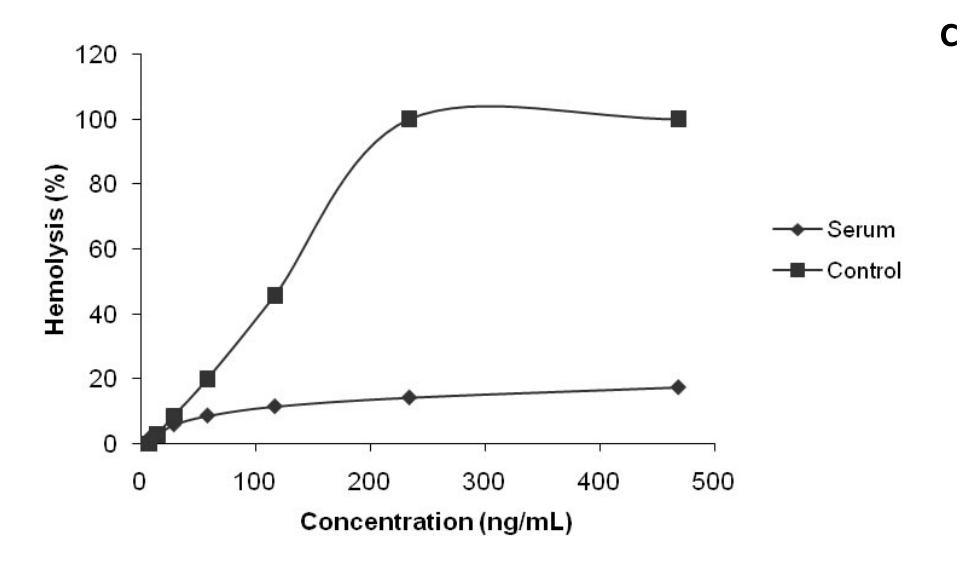
Figure 3. Physiological characteristics of the hemolytic fraction. ( A ) The effects of temperature, ( B ) pH and ( C ) serum on the toxin hemolytic activity. The toxin showed maximum activity at room temperature and in alkaline pH. The hemolytic activity was neutralized after addition of human serum ( C ). Data points shown are means of three independent experiments